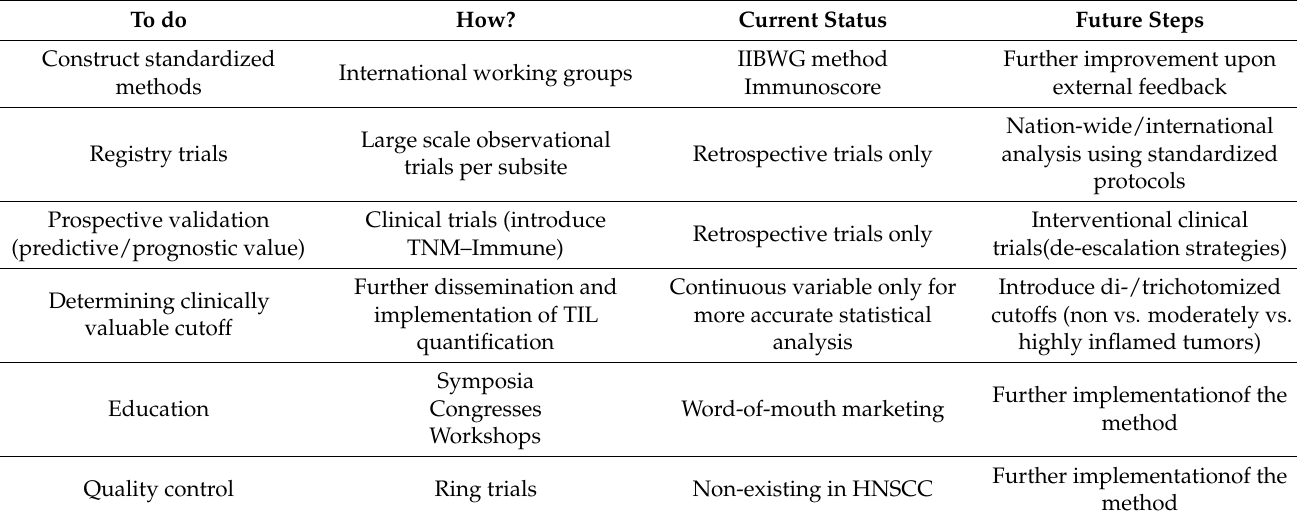
Table 2. Summary of future steps needed prior to clinical